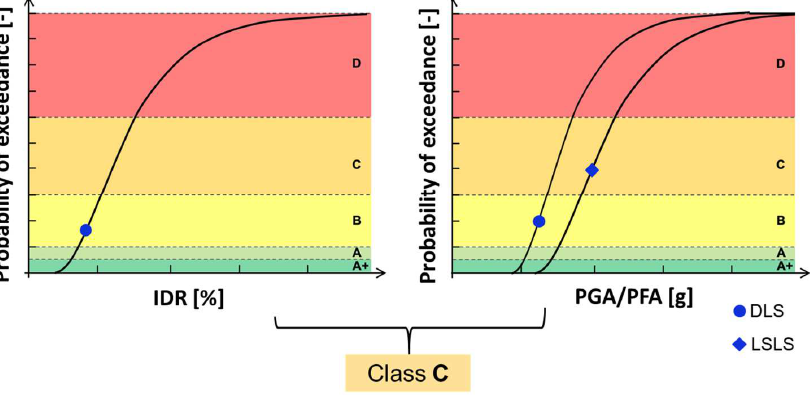
Figure 2. Graphical representation of seismic risk evaluation for a generic nonstructural element, according to the proposed approach.